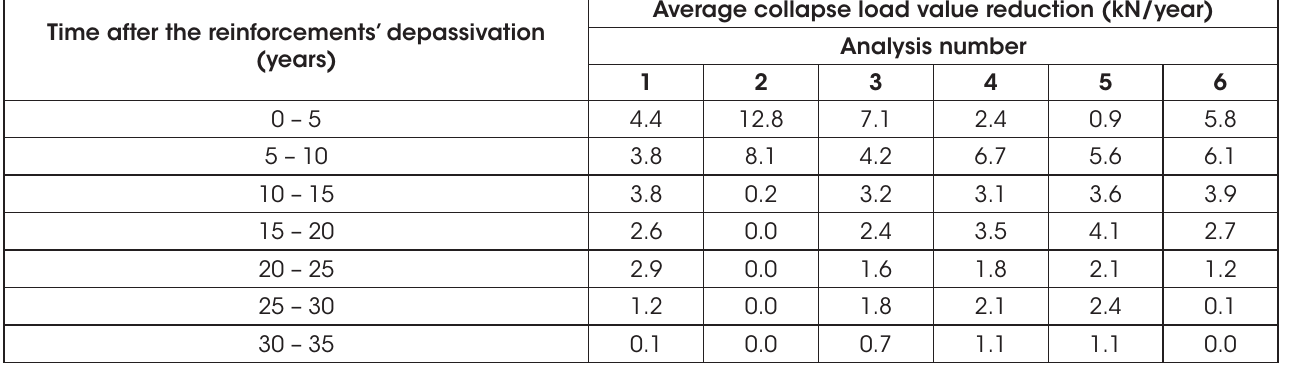
Evolution of the mechanical strength in terms of average annual rate Time after the reinforcements’ depassivation